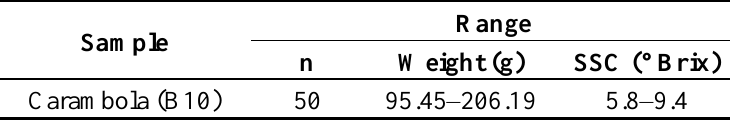
Table 1. Carambola samples used in the